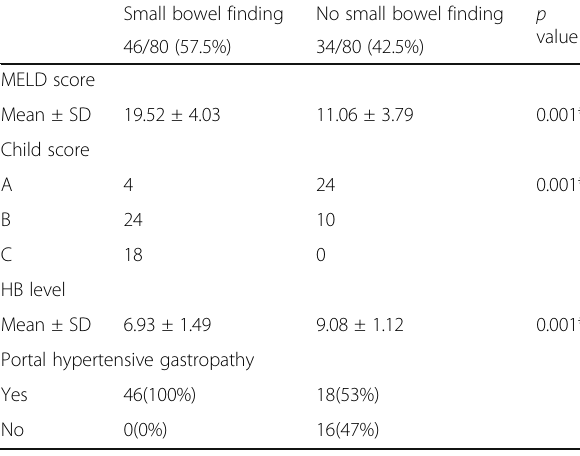
Table 2 Comparison between cirrhotic patients with and without small bowel